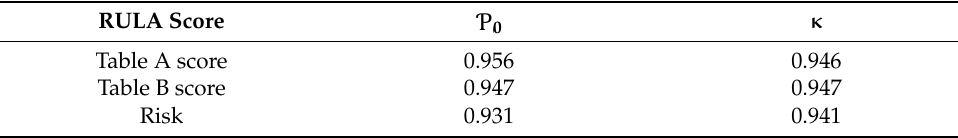
Table 10. RULA score performance with experts’ data.